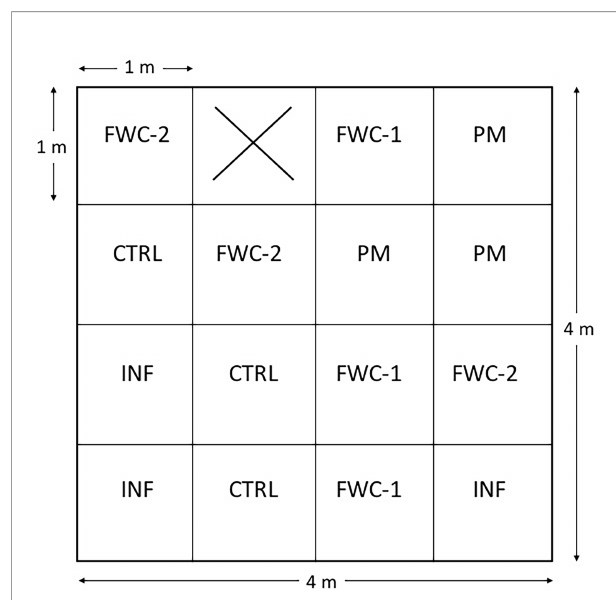
FIGURE 2 | Complete randomized design arrangement of four treatments (PM = poultry manure, FWC-1 = commercial marketplace compost from Dar es Salaam, FWC-2 = food waste compost generated in Mwanza, INF = inorganic nitrogen fertilizer, and CTRL = control). The treatment assignments were randomly generated. The X on the schematic represents a subplot that was not part of the experiment (i.e., no treatment).